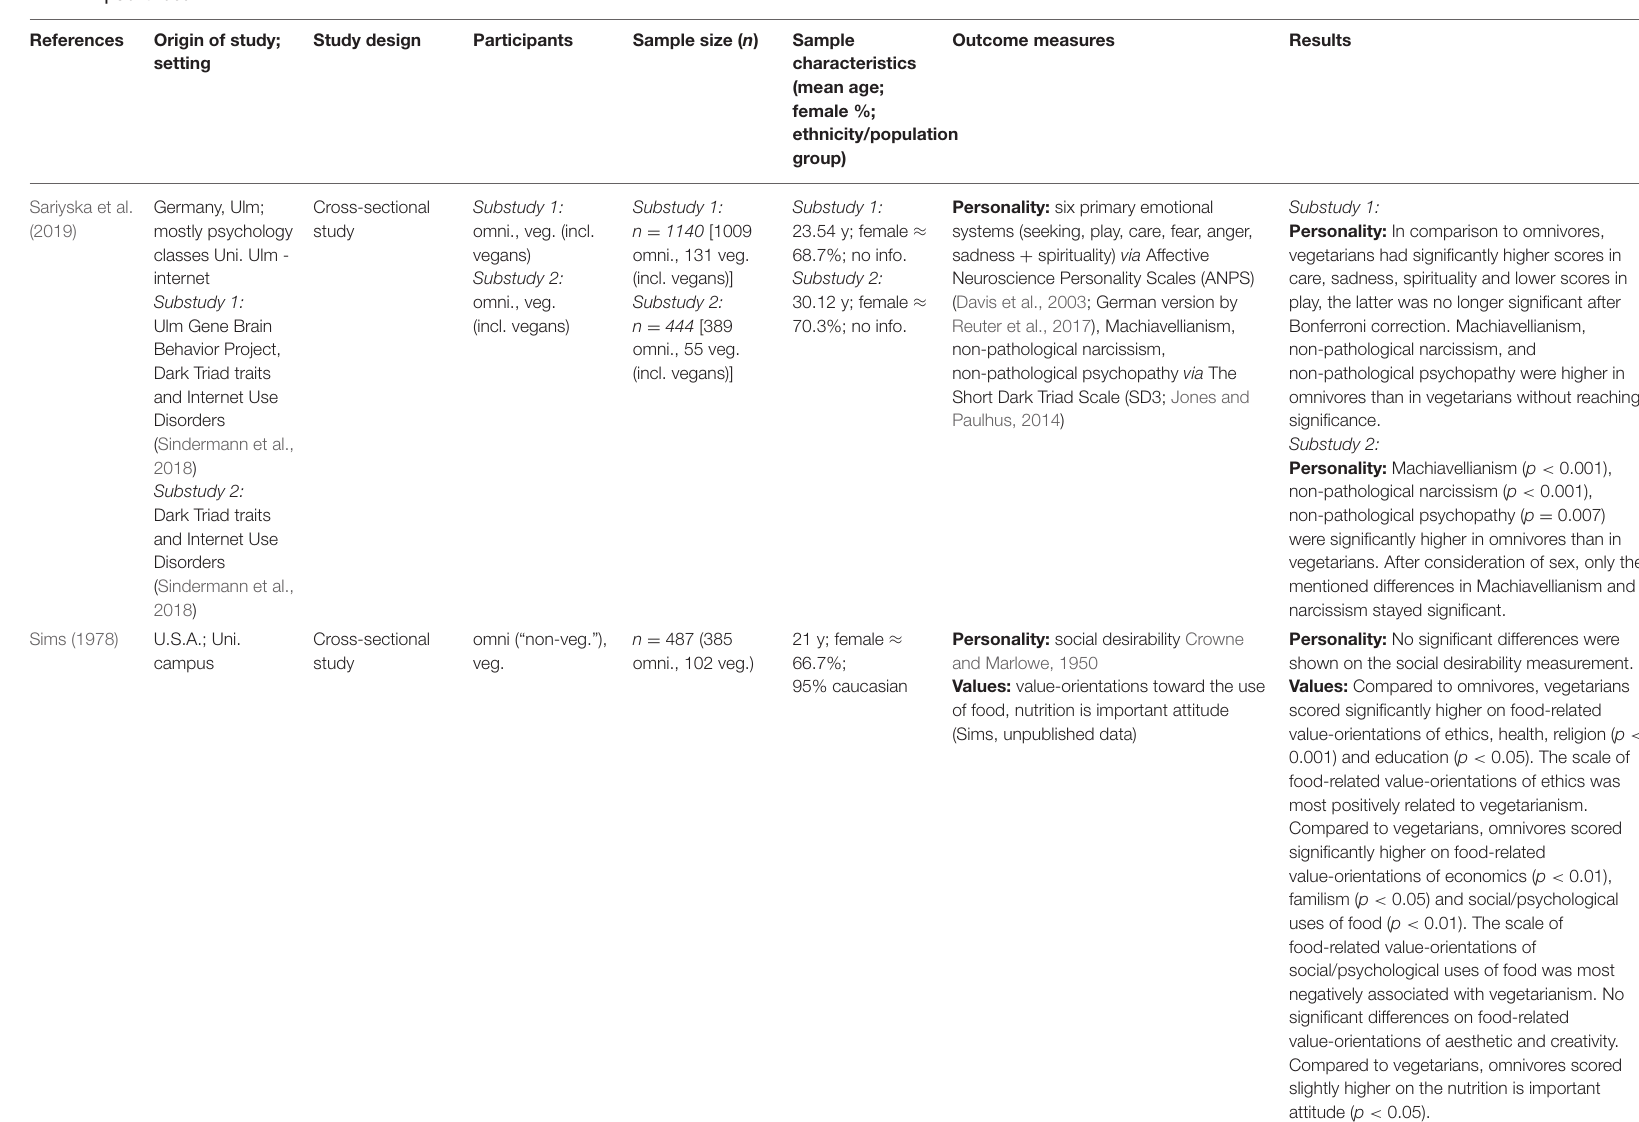
Personality: social desirability Crowne and Marlowe, 1950 Values: value-orientations toward the use of food, nutrition is important